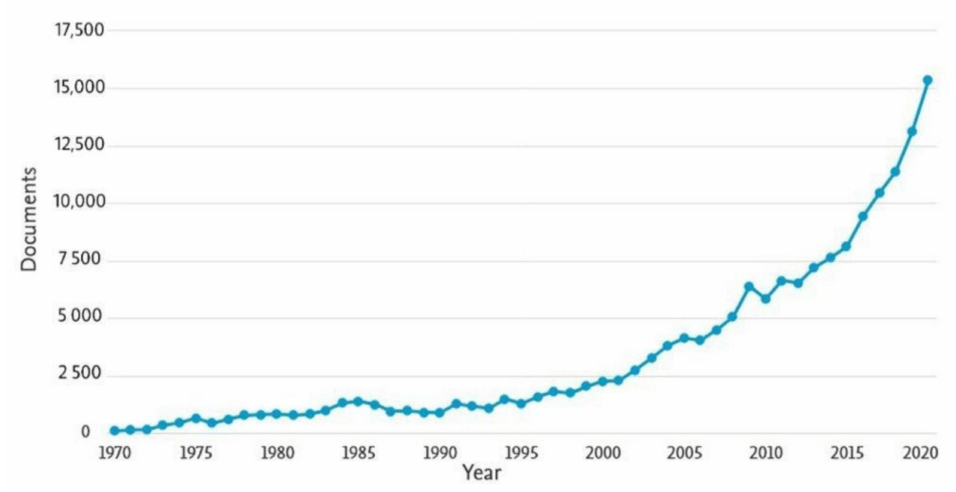
Figure 1. Publication activity curve by year based on the Scopus database using the keyword combination “wastewater” and